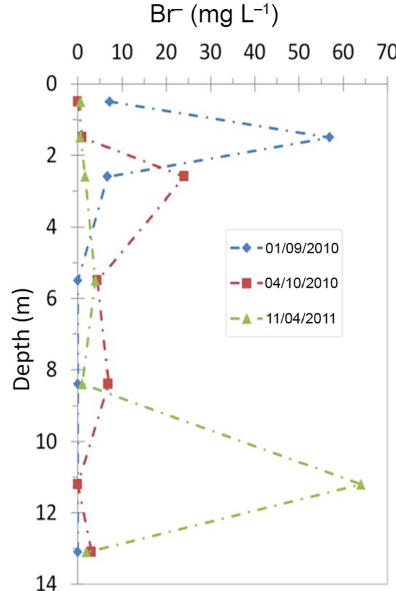
Figure 7. Variations in bromide concentration profile across the top 13m of the vadose zone during the infiltration experiments. Dates are given as day/month/year. Note that data points are aligned in a slanted orientation and interpolated as time